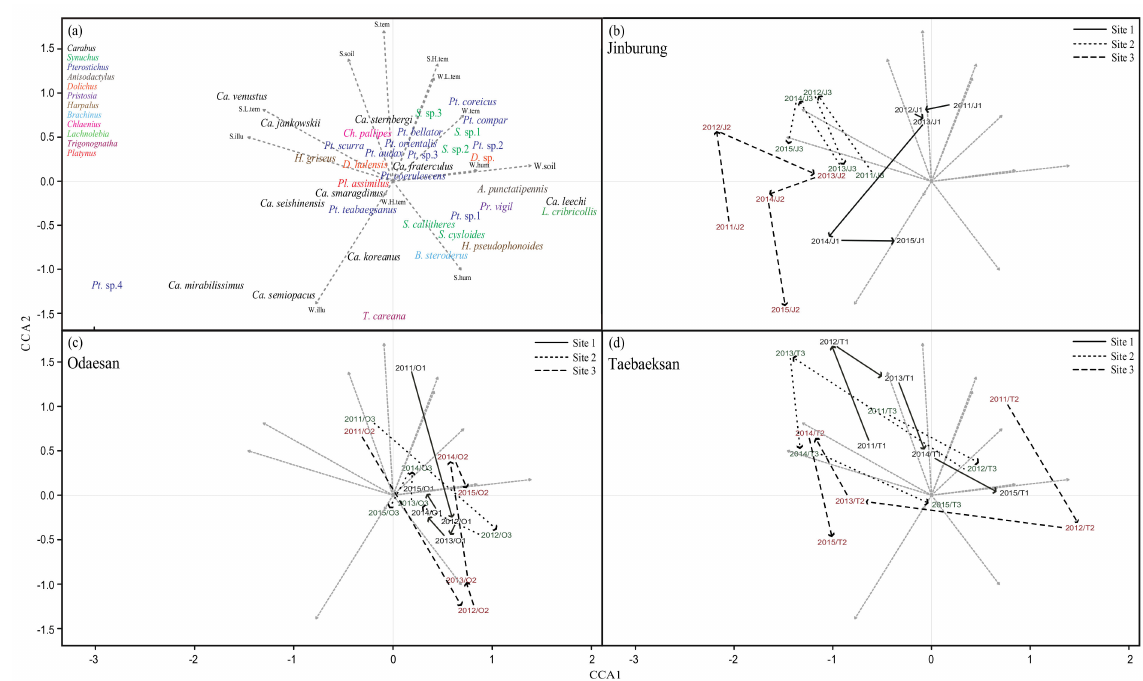
Figure 2. Canonical correspondence analysis (CCA) of temporal variation in communities. Arrows indicate changes in carabid beetle community composition in each of the 5 years of sampling: ( a ): each species, ( b ): carabid beetle communities in Jinburyung, ( c ): carabid beetle communities in Odaesan, ( d ): carabid beetle communities in Taebaeksan. Table 2. Spatial and temporal variation in carabid beetle